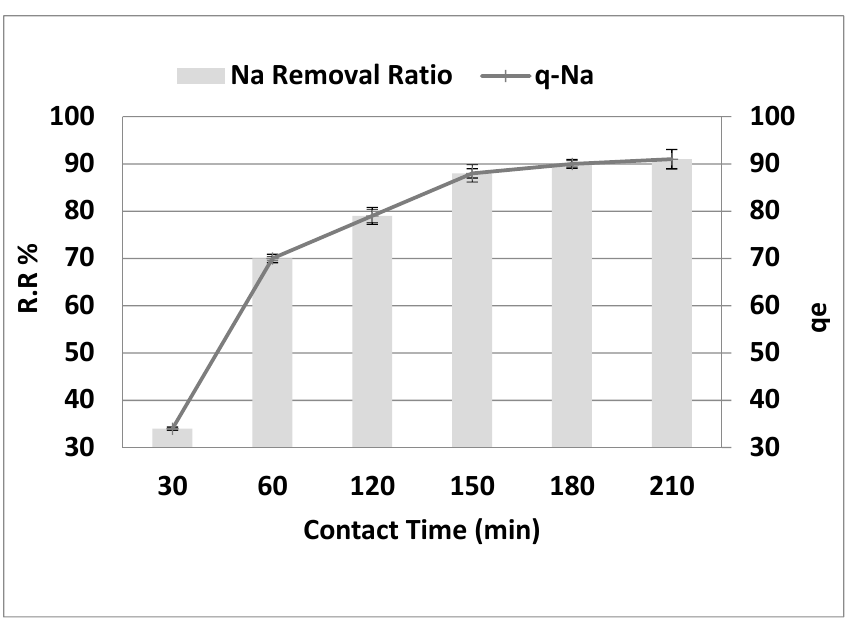
Figure 7. Effect of contact time on the removal efficiency and the adsorption capacity of NaCl, adsorbent dose = 10 g·L − 1 , pH = 4, and agitation speed = 300 rpm.